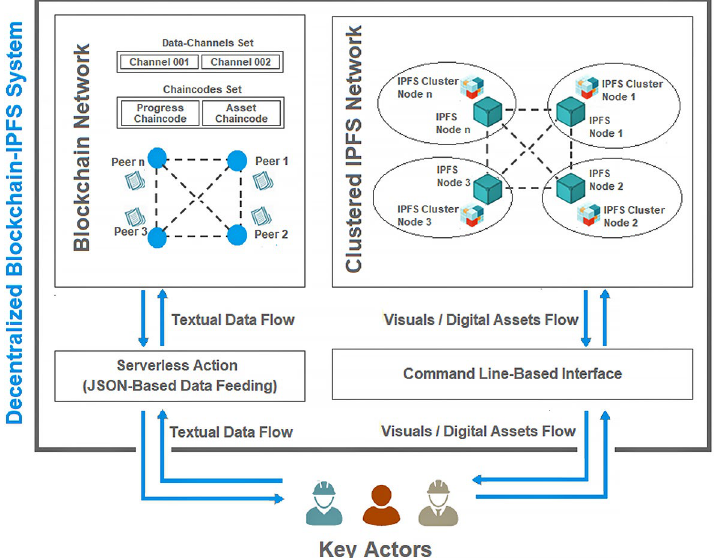
Figure 3. P2P information system for digitalizing and decentralizing the progress monitoring and control